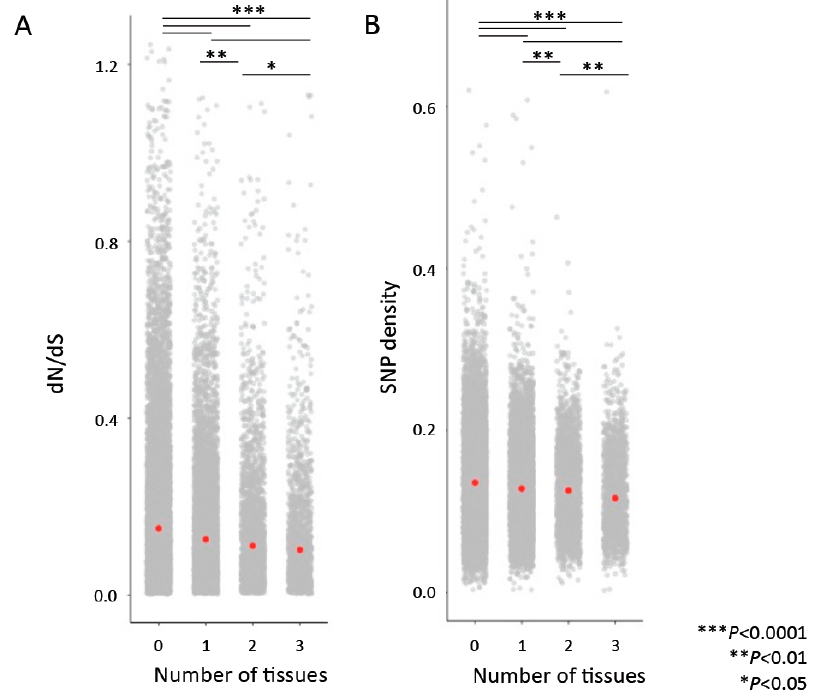
Figure 4. Genes that are “hubs” in more tissues are associated with lower dN/dS values ( A ) and lower SNP density ( B ). Comparisons were performed with permutation tests. Red points indicate median values.